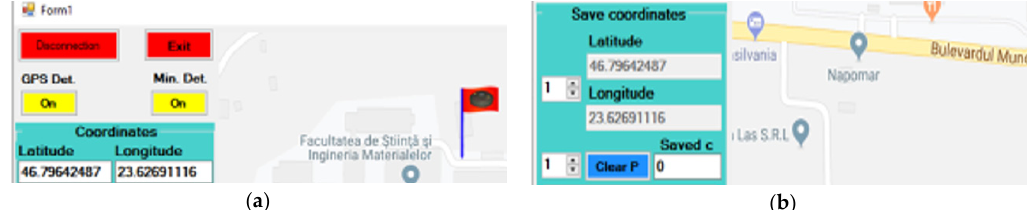
Figure 10. User-adapted graphic interface and the communication tool between the client and server: ( a ) coordinates definition; ( b ) data saving tool in the user interface and map location monitoring.